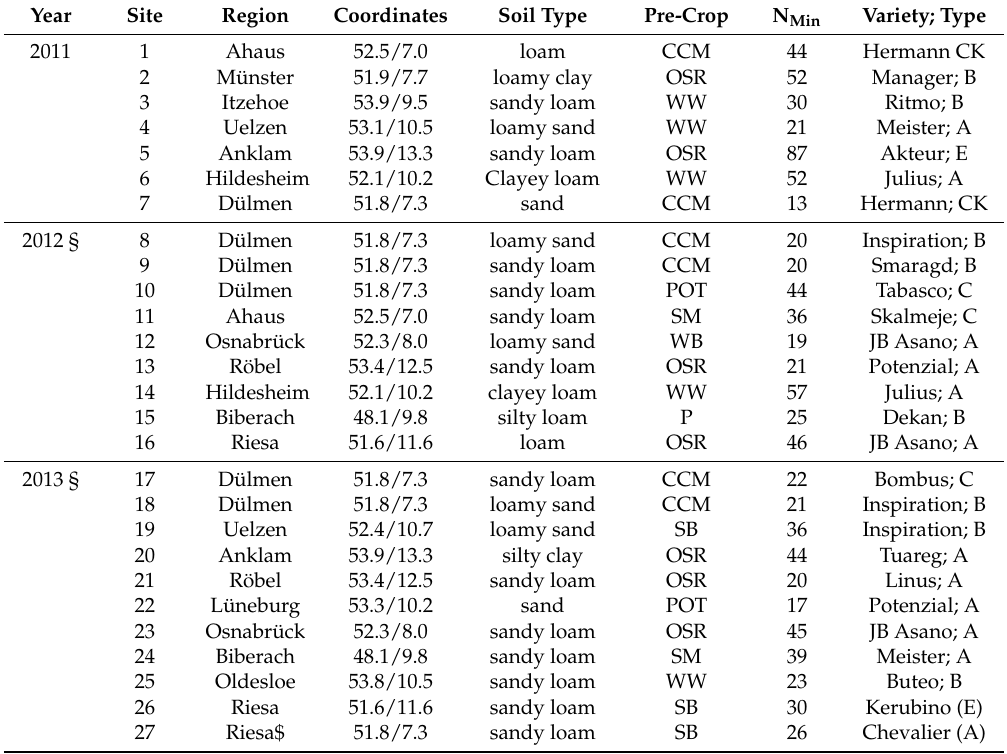
Table 1. Region, soil type, preceding crop, soil mineral nitrogen content (N Min ; kg N ha − 1 ) at vegetation start, variety name and wheat type. Wheat type classes A, B, and C refer to variety-specific bread-processing features. Class A types have regularly higher grain N concentration than class C types. Preceding crops (Pre-crop) were maize as silage (SM) or corn cob mix (CCM), potato (POT), winter barley (WB), winter wheat (WW), oilseed rape (OSR), sugar beet (SB) or pea (P). In the same region, different sites were